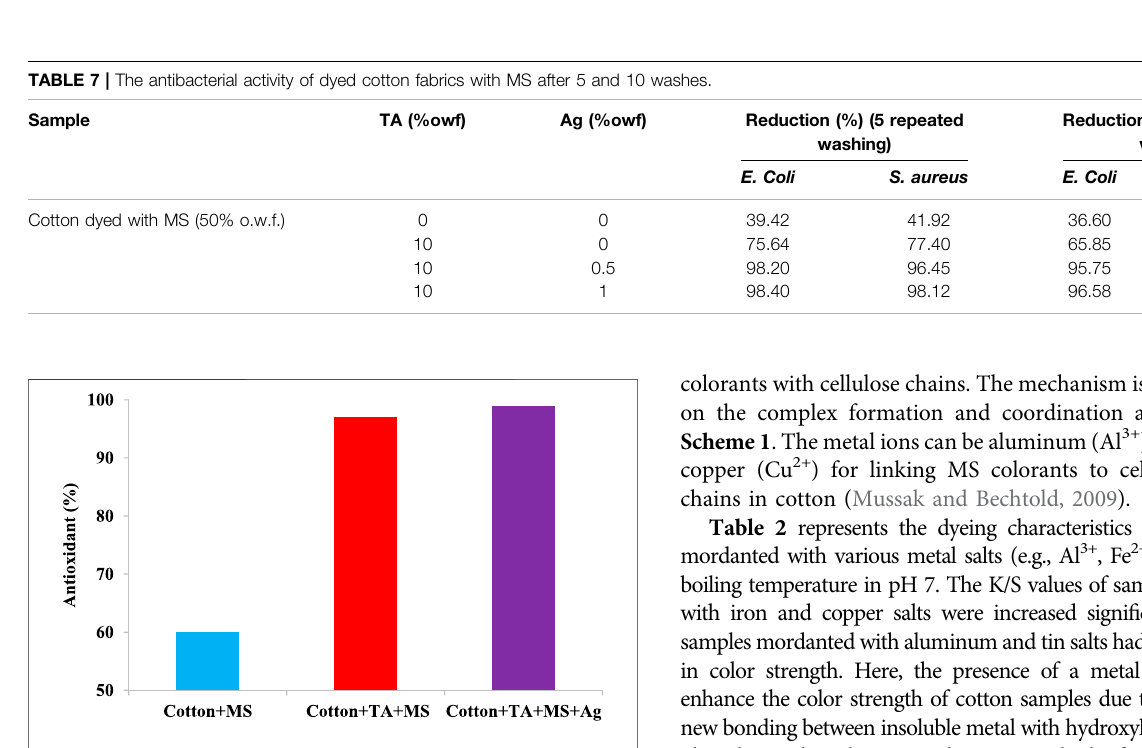
FIGURE 8 | The antioxidant activity of cotton samples dyed with MS extractsinpresenceofTAandAgNPs(MSdye:2%,t60 min,T80 ° C,Ag1%).